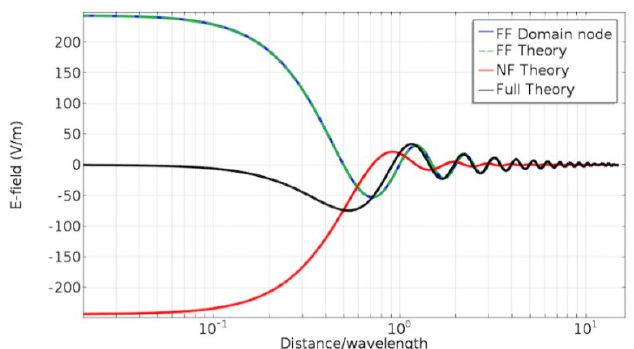
→ and the distance. p and the distance. 𝑝𝑝⃗